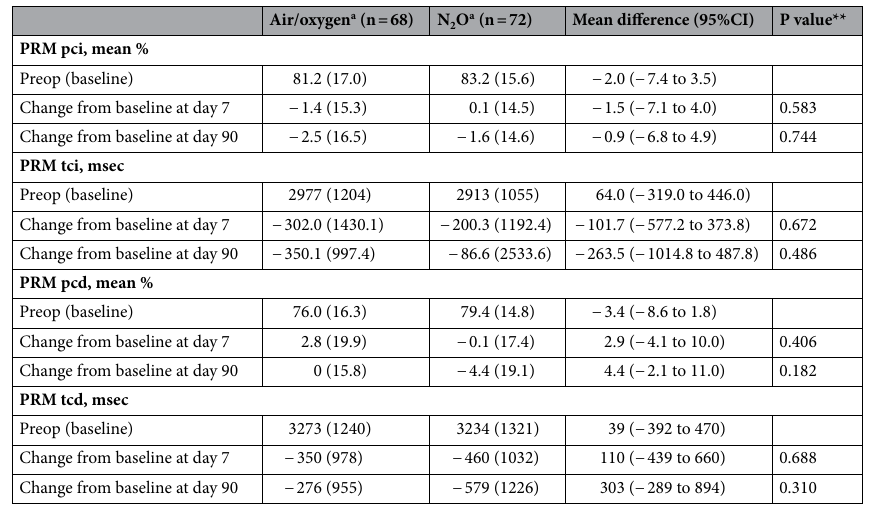
Table 3. Group differences for outcome measures of the pattern recognition memory test (PRM). PCI, proportion of correct answers immediate or the mean proportion of correct answers in the immediate test; TCI, time to correct answers immediate or the mean time to provide correct answers in the immediate test; PCD, proportion of correct answers delayed or the mean proportion of correct answers in the delayed test; TCD, time to correct answers delayed or the mean time to provide correct answer in the delayed test. **Change from baseline was compared between trial groups with t tests. In addition, a modification of the effect from day 7 to day 90 was tested with an interaction term in a linear regression model with mixed effects and was not found statistically significant (p-values from 0.16 to 0.51). a All data are presented as mean (±